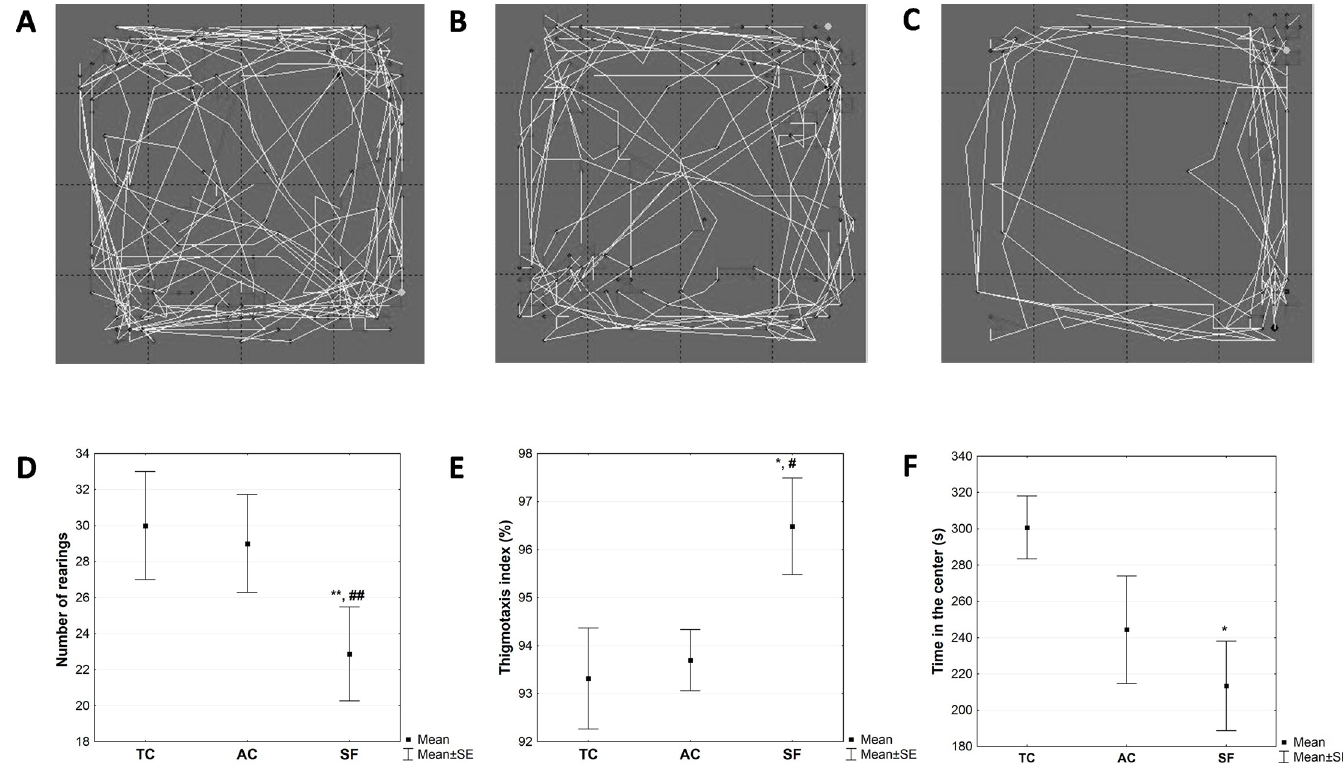
Fig 2. Representative traces of locomotor activity of animals in the open field test in the (A) treadmill control, (B) activity control and (C) sleep fragmentation groups. Number of rearings (D), thigmotaxis index (E) and time spent in the central area (F) in the open field test registered in animals upon sleep fragmentation method. The number of rearings was calculated as the number of times rat has propped on the hind legs. The index of thigmotaxis was defined as a ratio between the distance of ambulatory movement a rat made in the peripheral areas and the total distance of ambulatory movements in the open field test. Values are mean ± SEM. The statistical difference between groups was estimated by using One-Way ANOVA with Fisher’s LSD post hoc test ( � p < 0.05, �� p < 0.01 vs. TC; # p < 0.05, ## p < 0.01 vs. AC). For further details see the caption to Fig 1.